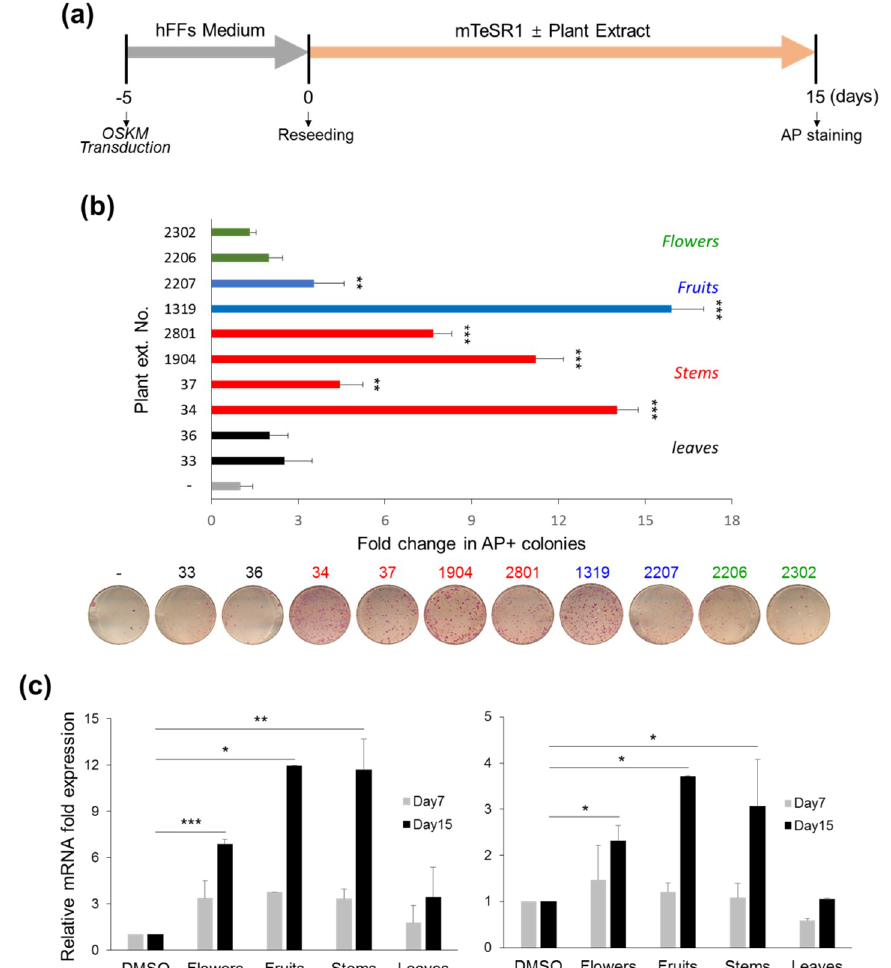
Figure 2. Identification of extracts from fruit and stem of CJ enhance human somatic cell reprogramming. ( a ) Schematic experimental procedure of human pluripotent stem cell (hiPSC) generation. The human foreskin fibroblasts (hFFs) were seeded at 1 × 10 5 cells per well in six-well plates, and cells were transduced with OSKM-Sendai virus (SeV) on the following day. After five days, OSKM-transduced hFFs were reseeded on Matrigel-coated 12-well plates and treated with or without different CJ extracts. ( b ) The groups of crude extracts from fruits or stems of CJ promote hiPSC generation. The number of AP+ colonies on day 15 post-treatment was used as a measure of the reprogramming efficiency. The relative fold changes in AP+ colonies compared with untreated controls (designated as 1) are presented. ( c ) The mRNA expression of the pluripotency markers Rex1 (left) and Nanog (right) at reprogramming days 0, 7, and 15 by qPCR. The results are presented as the mean + SEM ( n = 3). The statistical significance was determined using Student’s t -test (* p < 0.05, ** p < 0.01, *** p < 0.001).